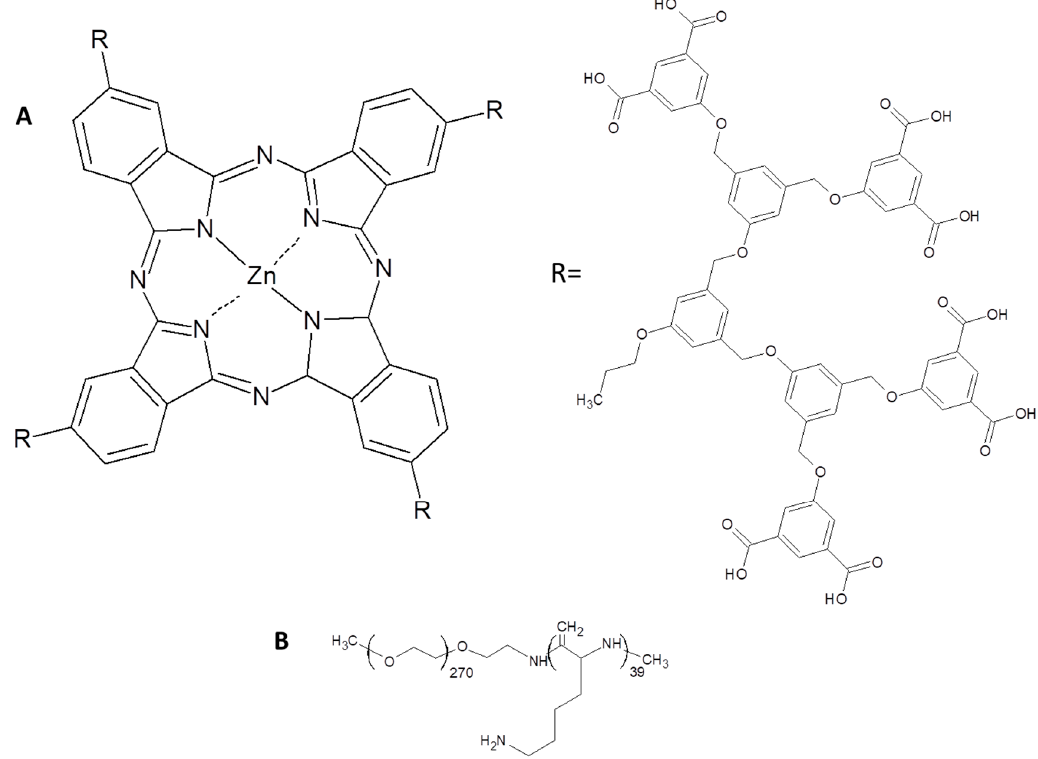
Figure 31. ( A ) dendrimeric ZnPc; ( B ) PEG–PLL used in [171].